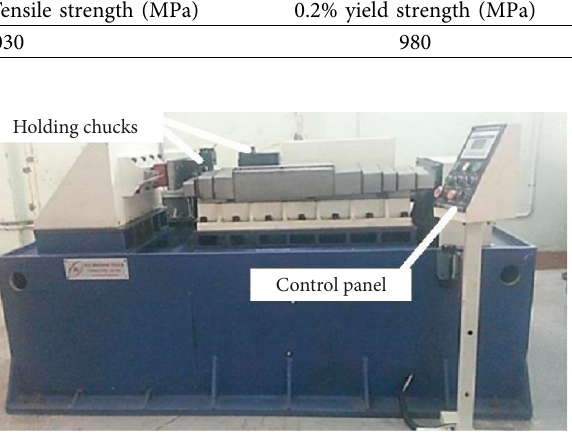
Figure 2: Photograph of the LFW machine used in this investigation.